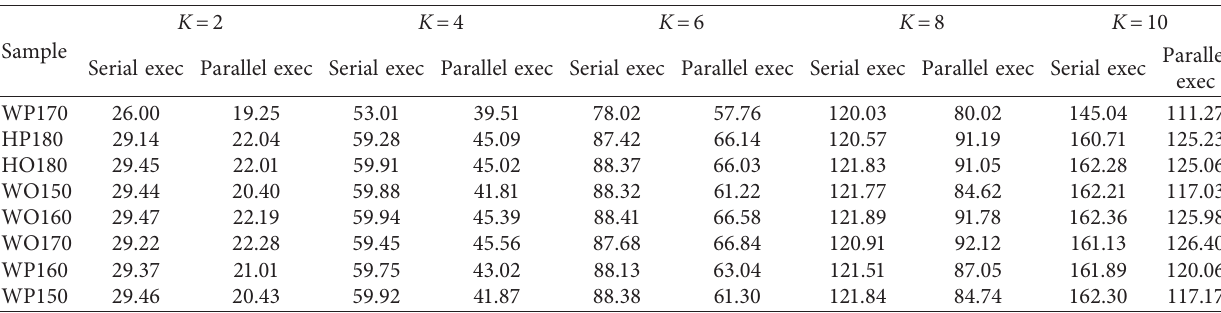
Table 8: Serial v/s parallel execution time (sec) for 3FT